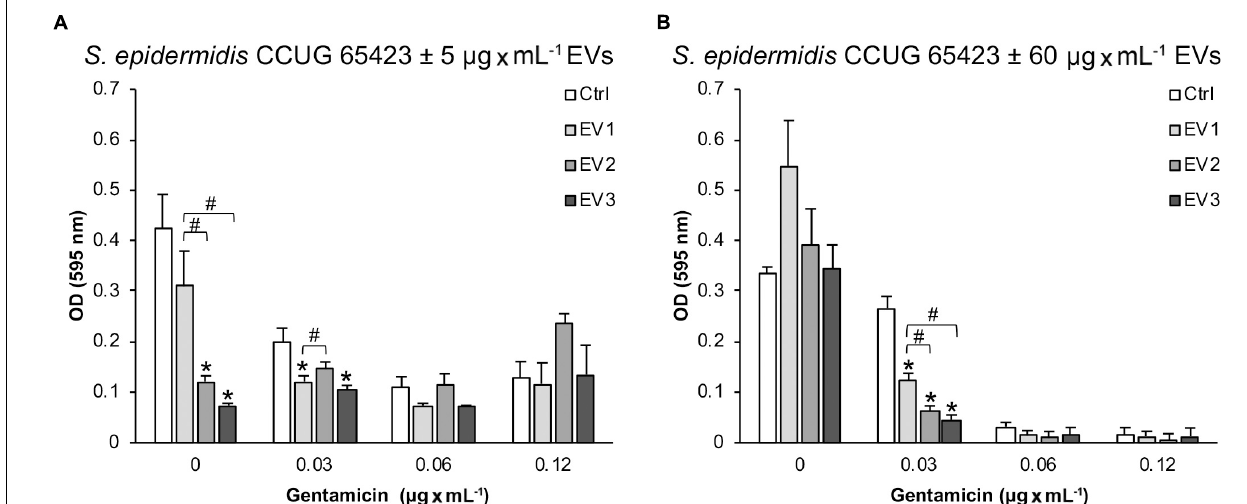
FIGURE 6 | The adherence of Staphylococcus epidermidis CCUG 64523 cells to tissue culture plates as determined by microtiter plate assay after 18 h of incubation with (A) 5 µ g × mL − 1 EVs and (B) 60 µ g × mL − 1 EVs. The data represent the mean ± SEM ( n = 3); * significant difference compared to the Ctrl; # significant difference between different groups of